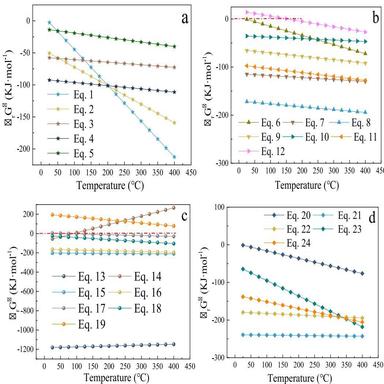
Gibbs free energy (ΔGθ ) versus temperature for reactions occurring during the roasting process with H2SO4. Each number in parentheses denotes the corresponding reaction equation in Table 3.